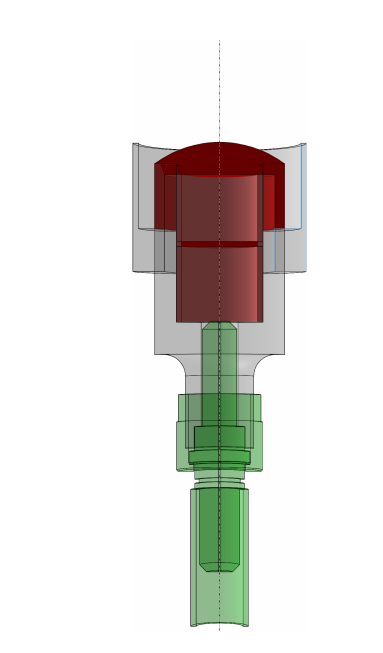
Figure 7. Section of our light collectors. The red parts are in teflon; the remaining is in metal. The tip of the fiber (SMA connector) is shown in